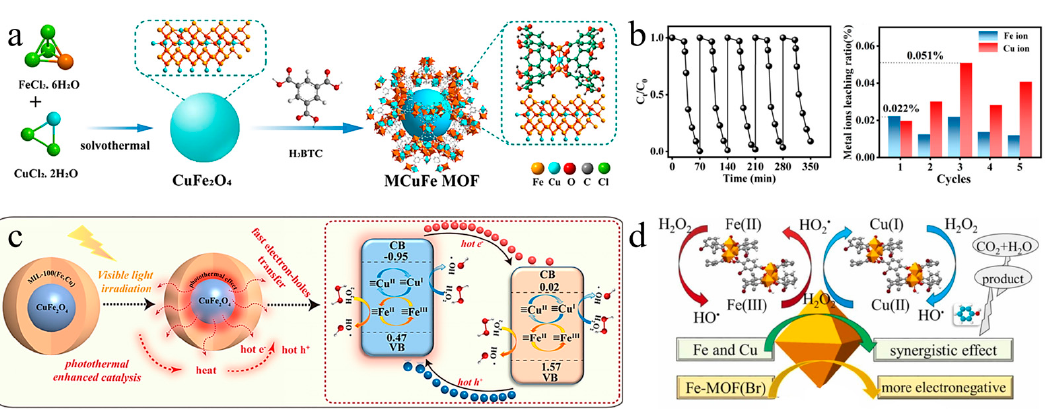
Figure 8. ( a ) Schematic diagram of MCuFe-MOF synthesis; ( b ) recycling and ion leaching of MCuFe-MOF; ( c ) Fenton reaction mechanism of MCuFe MOF glazing under visible light irradiation. Adapted with permission from Ref. [73], 2023, Elsevier. ( d ) Schematic diagram of the Fenton reaction